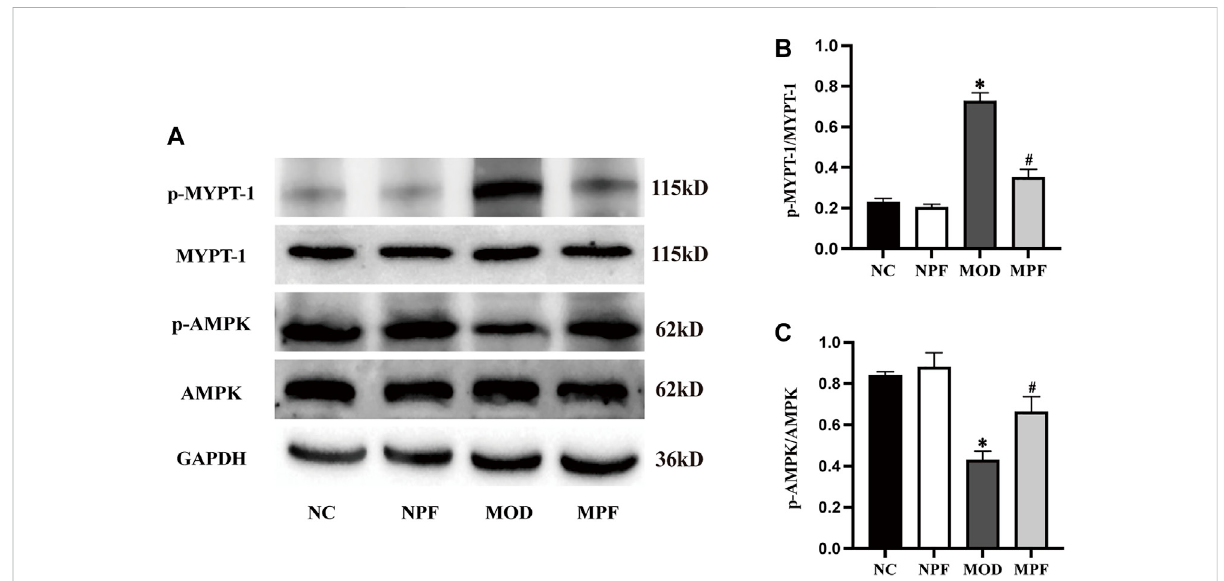
Effects of paeoni fl orin (PF) on p-MYPT-1/p-AMPK protein expression in the liver. (A) Representative p-MYPT-1 and p-AMPK expression bands. (B,C) Grey value of western blotting bands. The liver samples were obtained from the normal control group (NC), PF-treated control group (NPF), model group (MOD), and PF-treated model group (MPF). Data are presented as the mean ± S.E.M ( n = 3). * p < 0.05 vs. NC, # p < 0.05 vs.